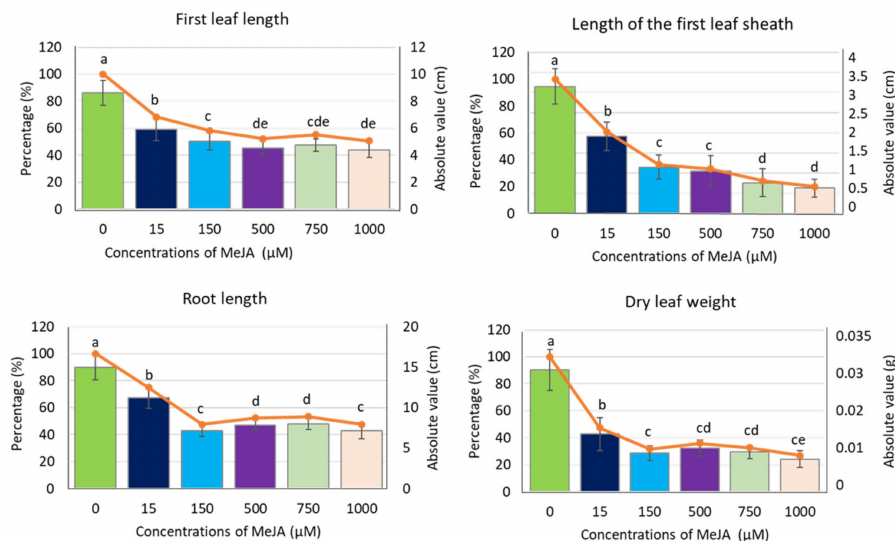
Figure 1. Growth parameters of barley seedling cv. ‘Sebastian’ after MeJA treatment. The parameters are presented as the absolute values (in centimetres or grams) and as a percentage of control, where 100% is the value for the seedling growth parameters without MeJA (control). Each of the values presented are the means ± SD, ten plants per one biological replication, three biological replications were used. Statistically significant di ff erences between di ff erent MeJA concentrations were assessed using a one-way ANOVA followed by the Fisher Least Significant Di ff erence (LSD) test ( p < 0.05) and are indicated by di ff erent